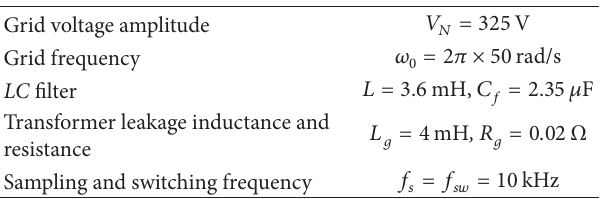
Table 1: Simulation and experimental